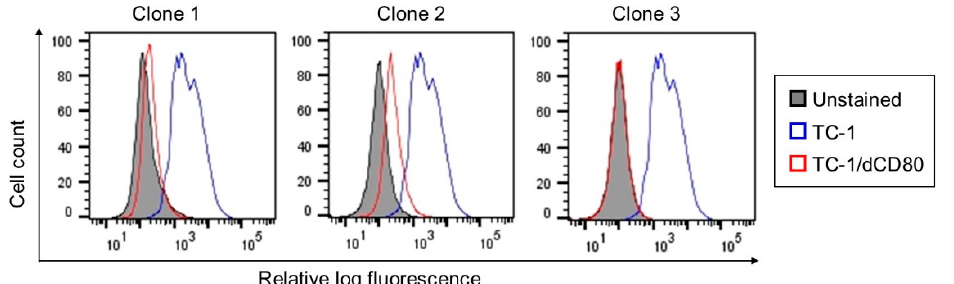
Figure 1. Flow cytometry analysis of co-stimulatory molecule cluster of differentiation (CD) 80 surface expression on the TC-1 cell line and TC-1/dCD80 clones. Unstained cells were used as the negative control.